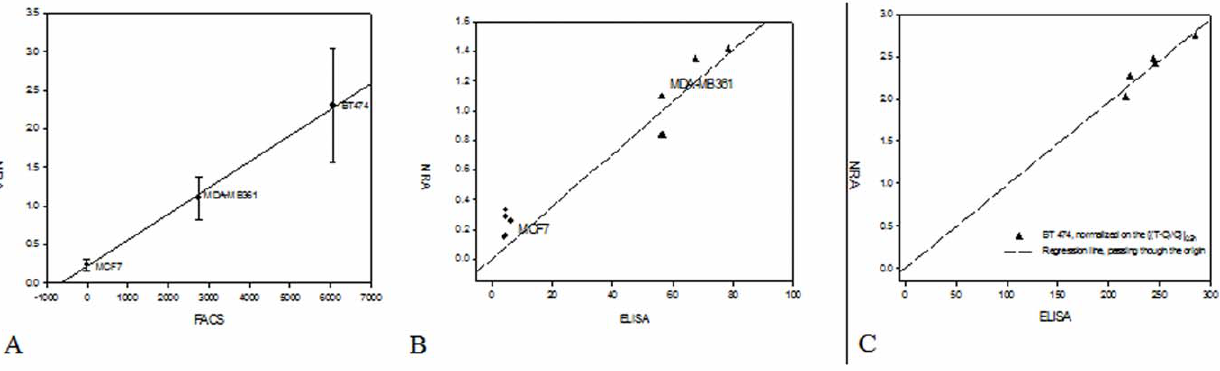
Figure 7. Relationship between normalized rates of accumulation of the probe and HER2 level. A. Relationship between normalized rates of accumulation of the probe and HER2 level (hours) in three types of HER2-positive tumors (BT-474, MDA-MB361, MCF7), estimated from in vivo fluorescence imaging and Affibody-DL-488 retention for corresponding cell lines to the same probe, found in vitro , using FACS B. Relationship between normalized rates of accumulation of the probe in individual HER2-positive tumors (MDA-MB-361, MCF7), estimated from in vivo fluorescence imaging and ELISA readings for the same tumor (ng/mg), dashed line is linear regression of MDA-MB-361 data, passing through the origin C. Relationship between normalized rates of accumulation of the probe in individual HER2 tumor BT474 (3 + ), estimated from in vivo fluorescence imaging and ELISA readings for the same tumor, dashed line is the linear regression, passing through the origin.